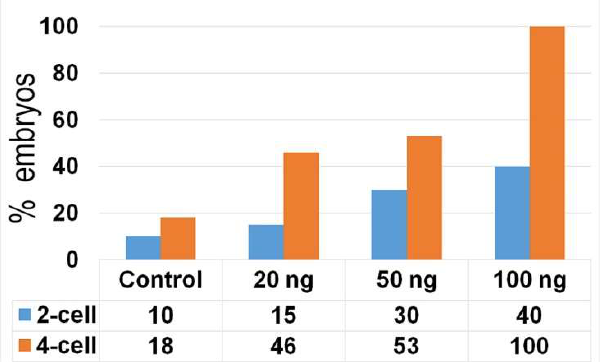
Figure 12. Percentage of the control and NCS-treated two- and four-cell embryos that contain micronuclei in at least one blastomere. micronuclei in at least one blastomere.